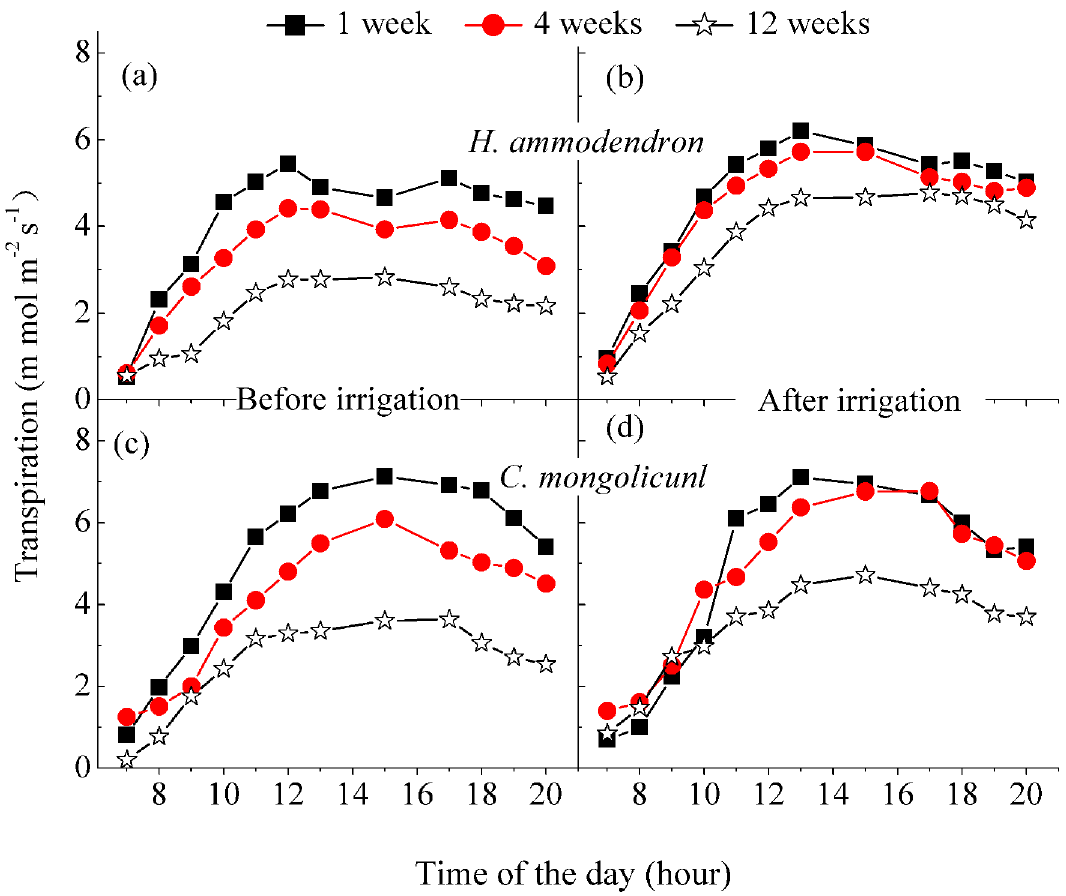
Fig 5. Diurnal pattern of transpiration for H . ammodendron (a, b) and C . mongolicunl (c, d) before and after irrigation for the five irrigation intervals. The data points for the 2-week interval fell betweenthose of the 1 and 4 weeks; those of the 8-week interval fell betweenthose of 4 and 12 weeks. Error bars represent the standarddeviationof the